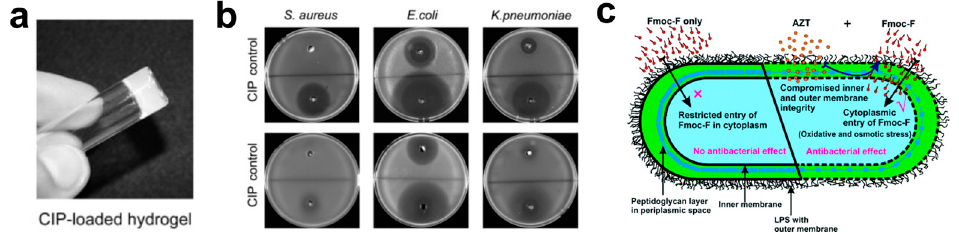
Figure 10. ( a ) D LFF hydrogel loaded with ciprofloxacin (CIP). ( b ) Zone of inhibition experiments demonstrating enhanced antimicrobial activity of CIP-loaded gels (CIP), relative to unloaded gels (control) against multiple bacterial species. Adapted from [147] with permission from Elsevier. ( c )